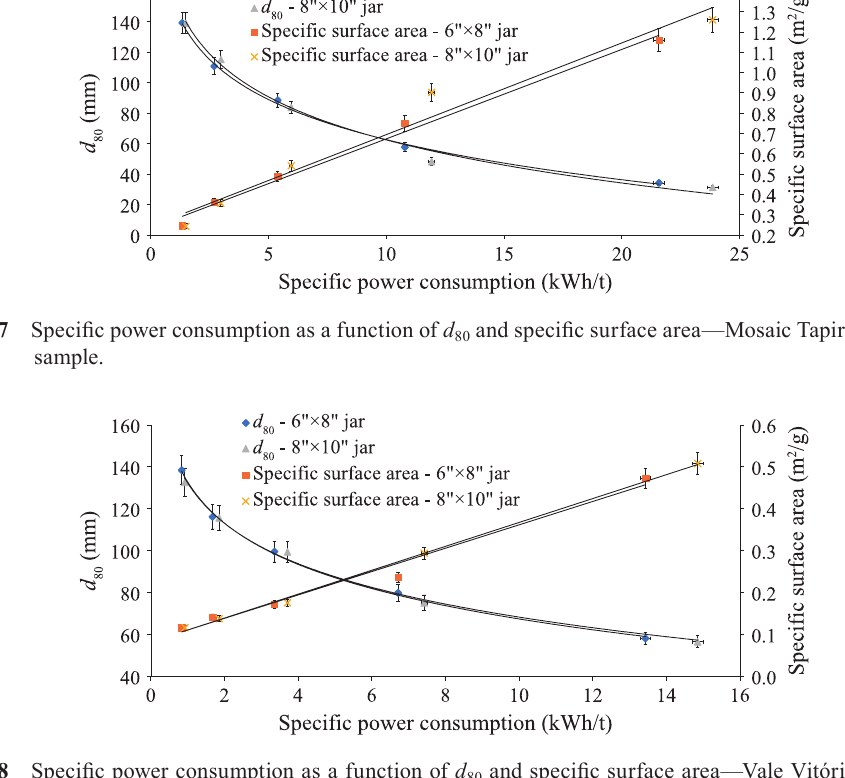
Fig. 8 Specific power consumption as a function of d 80 and specific surface area—Vale Vitória